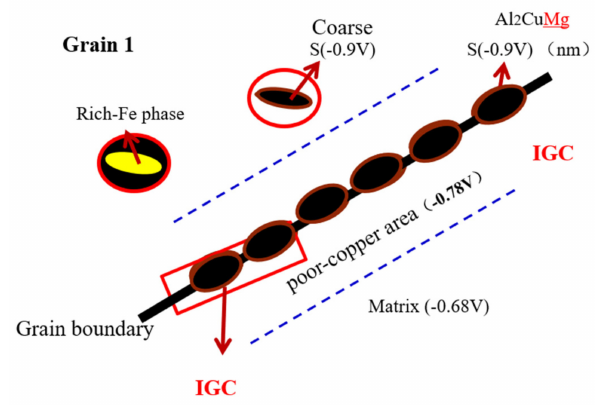
Figure 15. Corrosion mechanism of 2xxx series aluminum